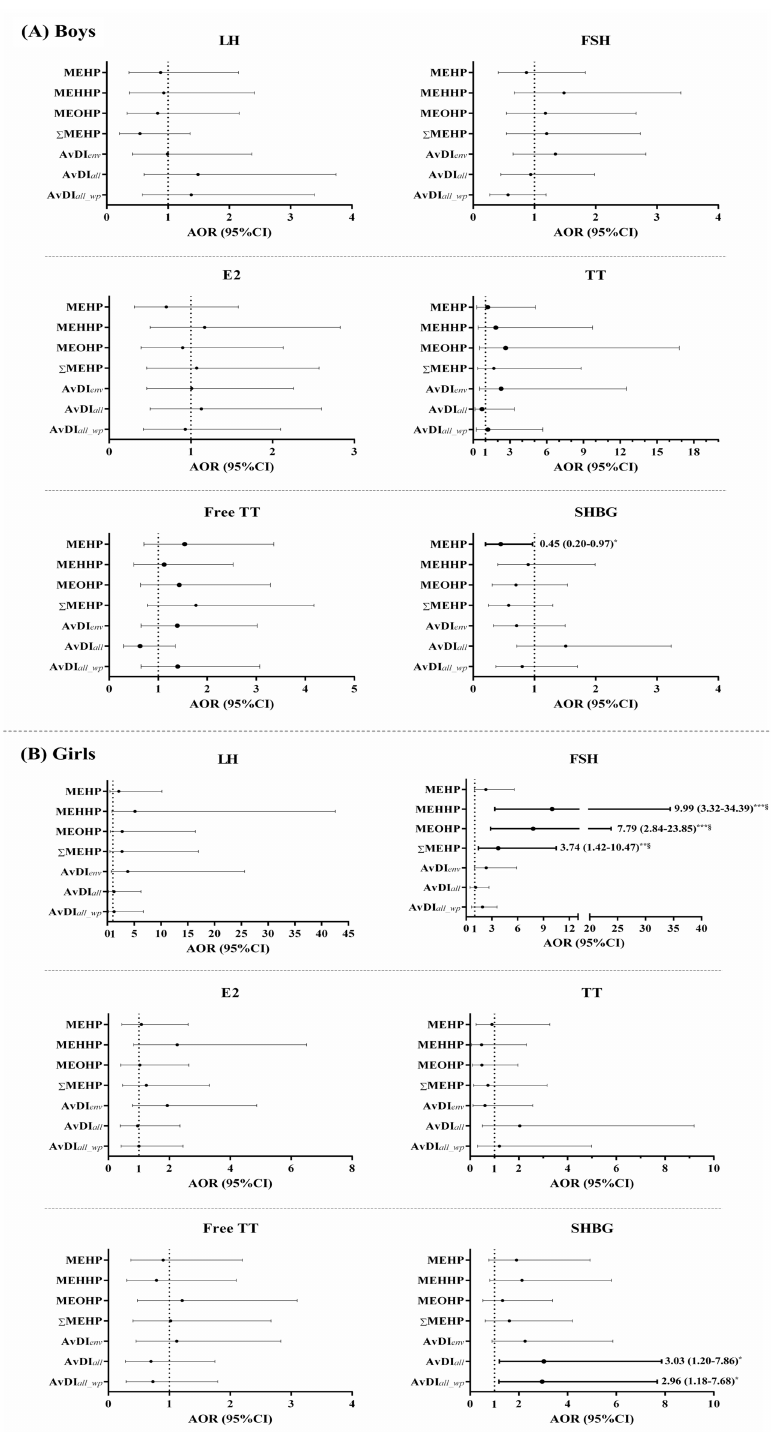
Fig 2. Odds ratios (95% confidence intervals) for the high–low reproductive hormone concentrations between DEHP exposure parameters grouped by median as high and low exposures, with adjustments for age and birth weight (n = 222). The results for (A) boys (n = 132) and (B) girls (n = 90). Numbersin the figures indicatedadjusted OR (95% CI). Boldfaceindicatesachievementof p < 0.05. * p < 0.05, ** p < 0.01, and *** p < 0.001 ( § p < 0.0071indicatesa statistical significant). Abbreviations: DEHP,